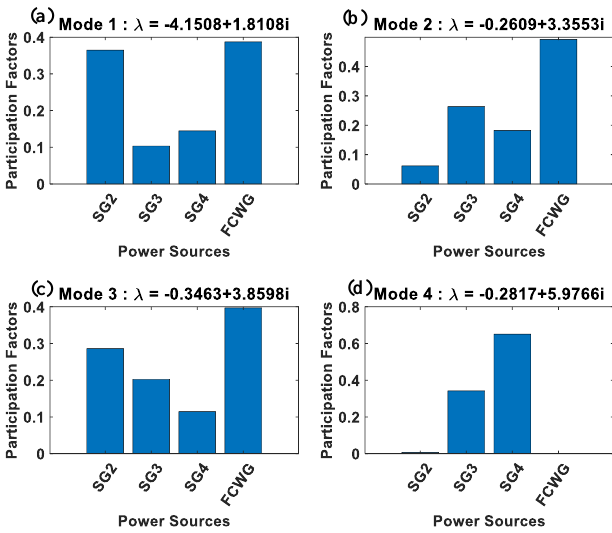
Figure 15. Strong interaction case: participation of power sources in EOMs when SG1 is replaced with FCWG: ( a ) closed-loop Mode 1; ( b ) closed-loop Mode 2; ( c ) closed-loop Mode 3; ( d ) closed-loop Mode 4.